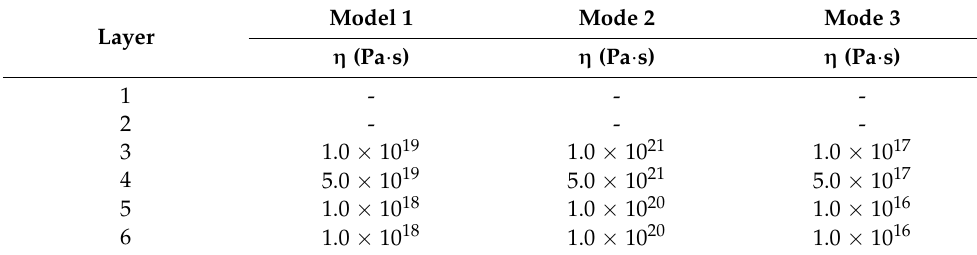
Table 5. Models used to analyze the effect of different combinations of viscosities for both the upper mantle and lower crust. Model 1 is the original model used in this work. Model 2 has the maximum value of the viscosity combination. Model 3 has the minimum value of the viscosity combination.